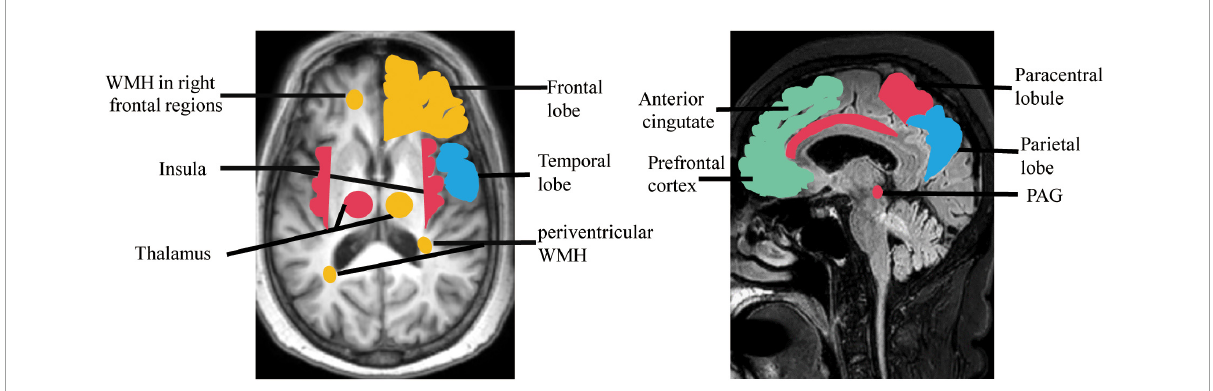
FIGURE1 Regions showing brain damage in UD (red, green) and VCI (blue), and the overlapping regions (orange). PAG, periaqueductal gray; WMH, white matter